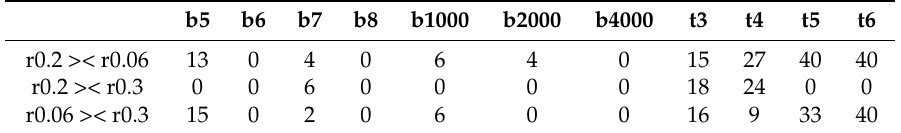
Table 9. Significant difference scores (%) between the three search radius (laboratory study).